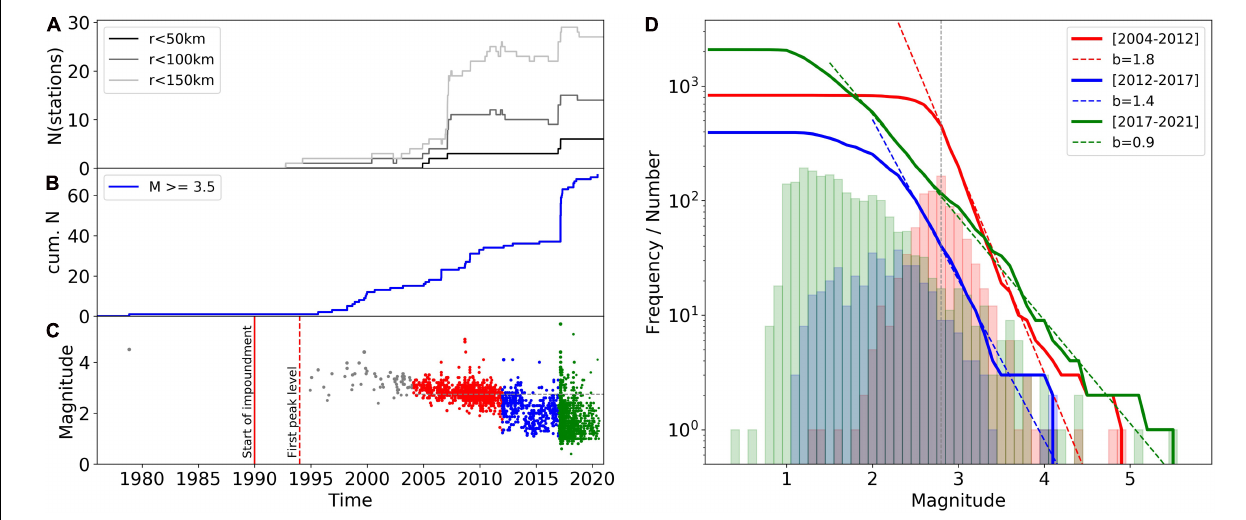
FIGURE 3 | Frequency-magnitude distribution of the observed earthquakes: (A) Number of seismic stations with a distance less than 50, 100, or 150 km from the 2017 M w 5.5 epicenter as a function of time; (B) cumulative number of M ≥ 3.5 events and (C) magnitudes of all recorded events versus time, where colors refer to the different periods analyzed separately in panel (D) and the horizontal dashed line indicates the completeness magnitude M C = 2.75; (D) histograms and cumulative distributions with GR-fits (dashed lines, the corresponding b-values are provided in the legend). Additional plots of the frequency-magnitude distributions and the b-value calculation are presented in the Supplementary Figure 1 .